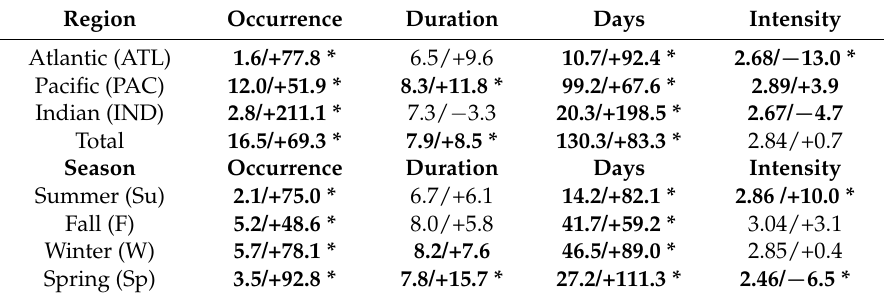
Table 3. As in Table 2, except for the